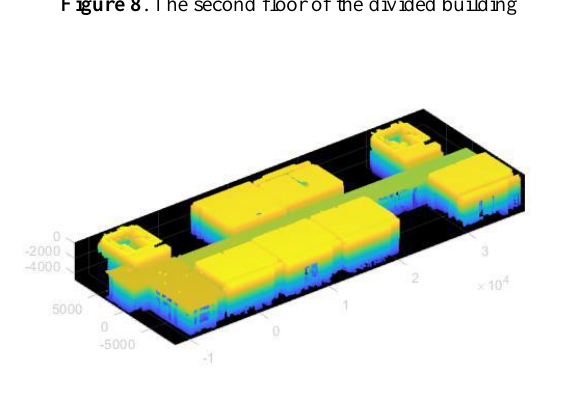
Figure 10 . Point cloud with beam part